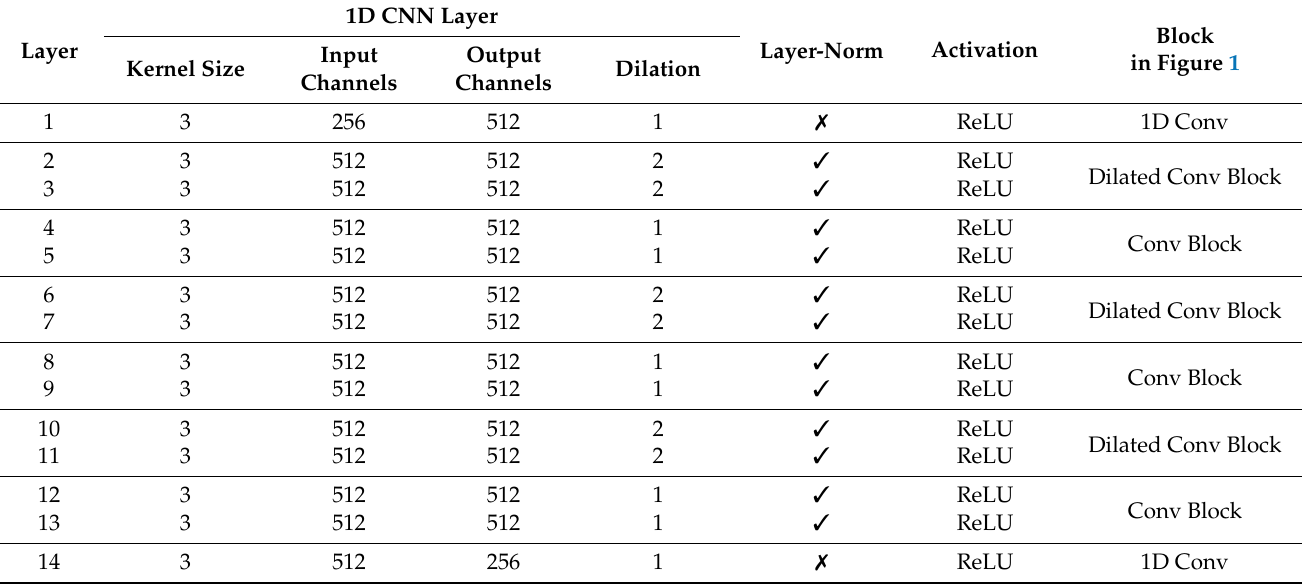
Table 1. Conventional module architecture in